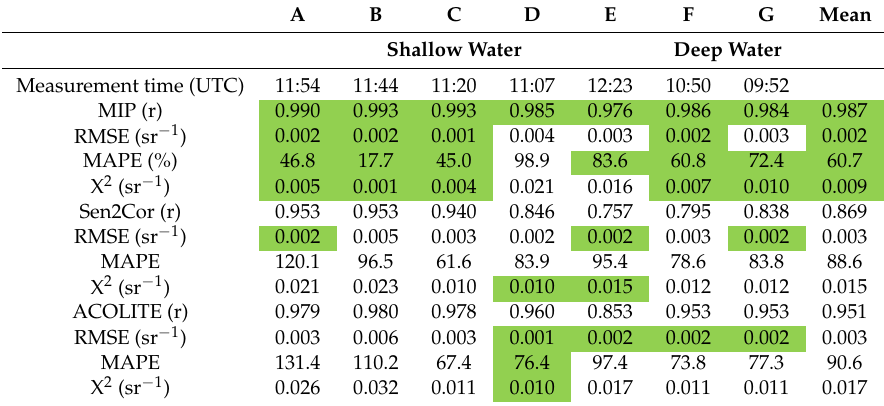
Table 1. Performance indicators of resampled in situ and atmospherically corrected spectra at measurement sites in optically shallow ( A – E ) and deep ( F – G ) water. Green colour highlights the atmospheric correction algorithm with the best